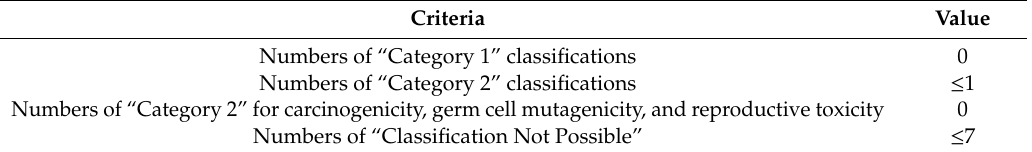
Table 3. Process of selecting chemicals that are relatively less hazardous.